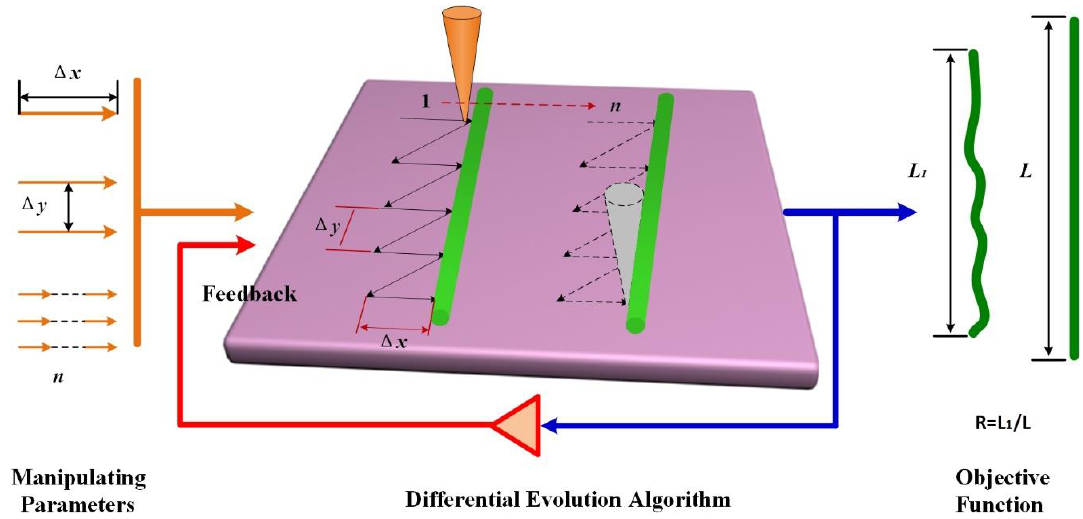
Figure 1. Schematic of the manipulation system. The diagram depicts the tip pushing carbon nanotubes (CNTs) technique loop used for manipulating parameter optimization based on the differential evolution (DE) algorithm and three pushing parameters. Pushing distance ∆ x , the interval between the adjacent pushing path ∆ y , and pushing step n were fed into the manipulating system. The length ratio of CNT before and after pushing operation was the objective function used to suggest new parameters in the next iteration. The optimization process continues until reaching the desired state.